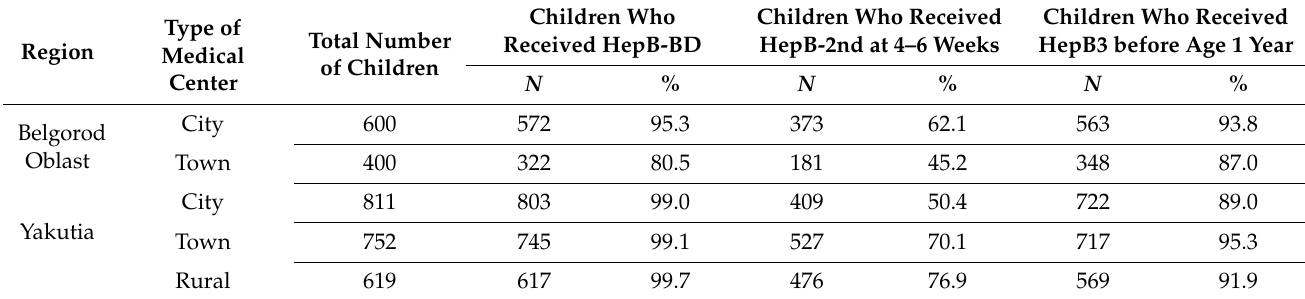
Table 2. Rates of coverage with timely HepB-BD, timely HepB-2nd and HepB3 by location of the medical center.